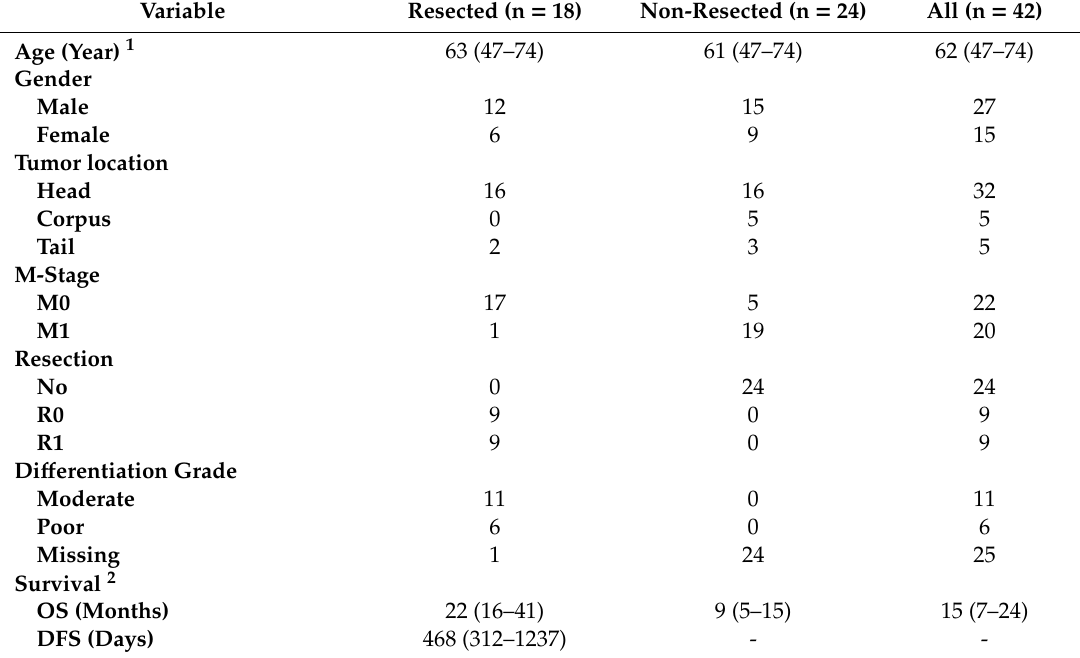
Table A2. Patient characteristics.